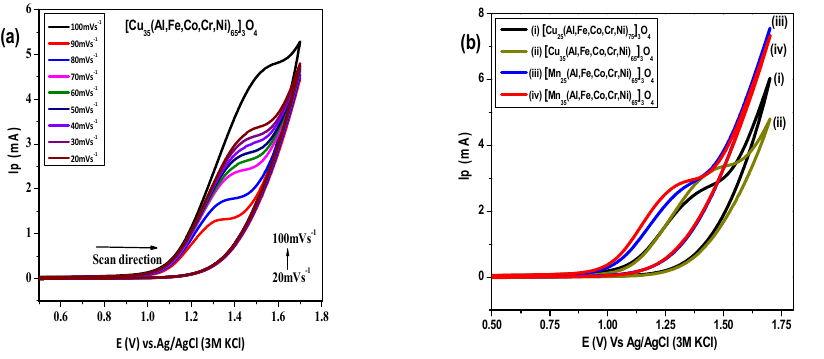
Figure 6. Cyclic voltammograms of water oxidation in 1M KOH + 1M CH 3 OH using [Cu 35 (Al,Fe,Co,Cr,Ni) 65 ] 3 O 4 ( a ), and comparative cyclic voltammograms for different percentage compositions of Cu and Mn in (Al,Fe,Co,Cr,Ni) HEO ( b ).